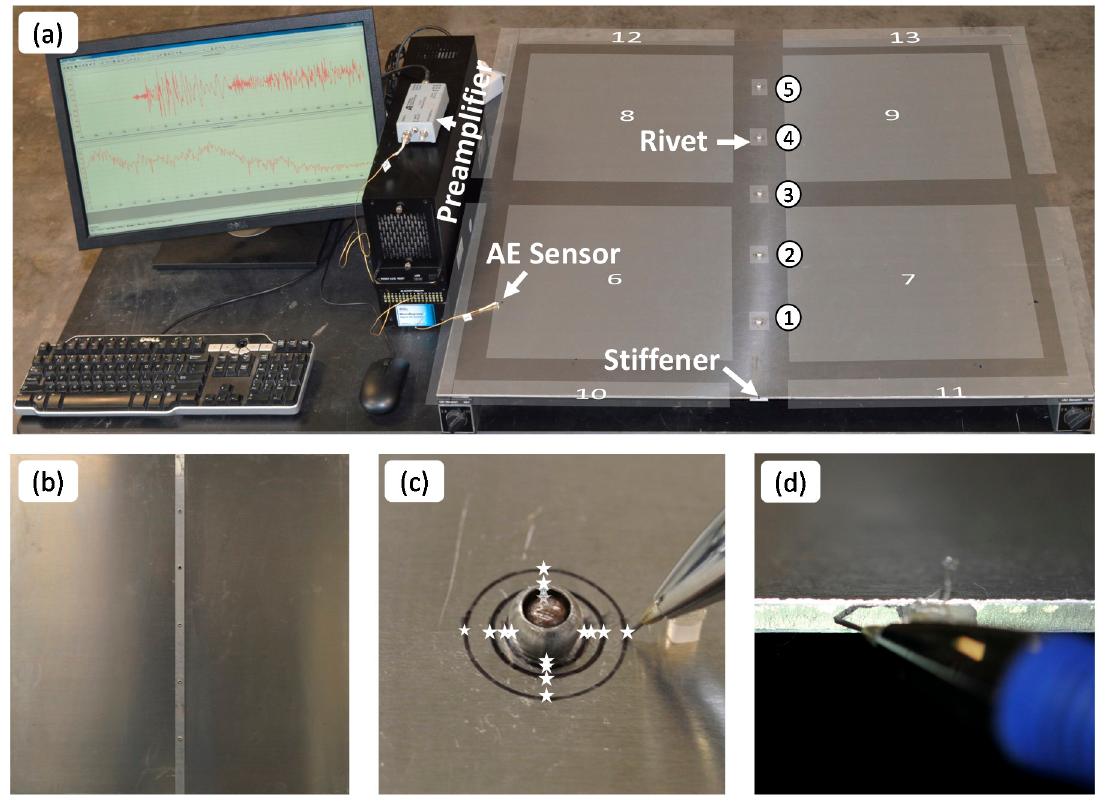
Figure 8. ( a ) Experimental setup, thirteen zones are labeled in the image; ( b ) stiffener on the back of plate; ( c ) a pencil lead break test next to a rivet (zones 1–5); ( d ) a pencil lead break test at the edge of the plate (zones 10–13).